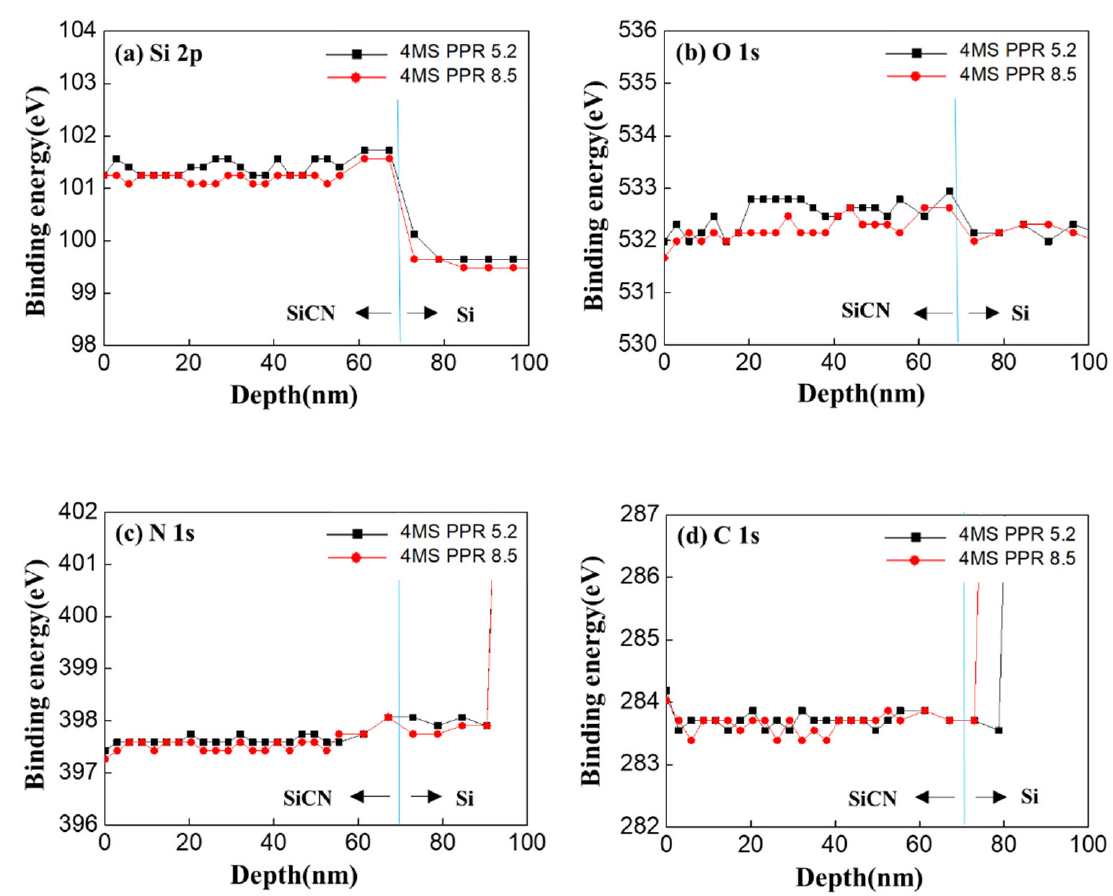
Figure 7. Comparison of binding energies of 4MS PPR of 5.2% and 4MS PPR of 8.5% at the peak of intensity ( a ) Si 2p, ( b ) O 1s, ( c ) N 1s, ( d ) C 1s.